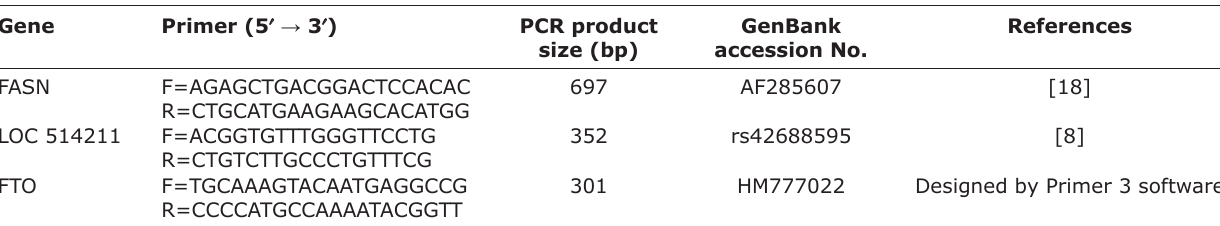
Table-1: Primer pairs used to amplify gene fragments. Gene Primer (5 ′ → 3 ′ ) PCR product